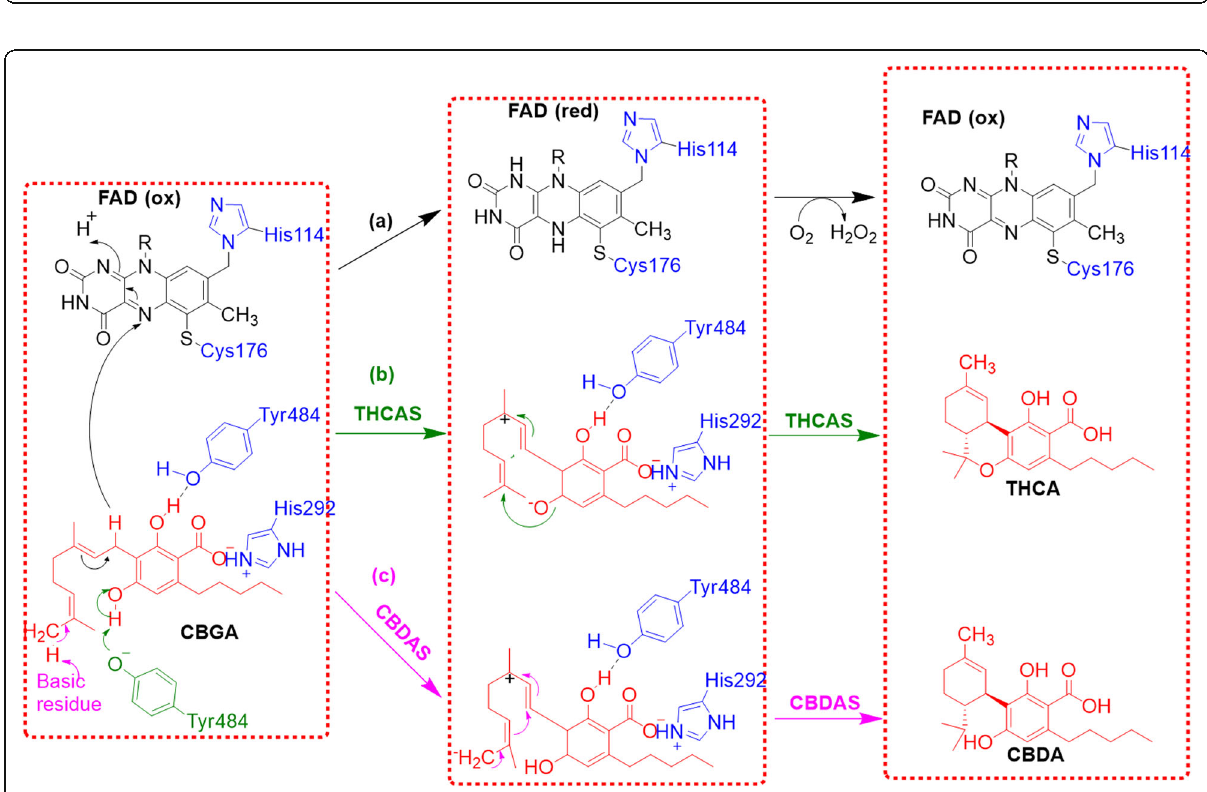
Fig. 4 Proposed mechanism for the formation of olivetolic acid (OLA) by olivetolic acid cyclase (OAC)